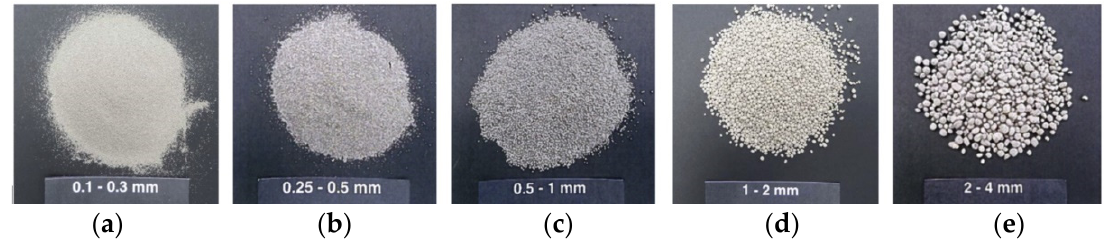
Figure 2. Appearance of LWAs: Expanded waste glass aggregates with 5 different diameters of ( a ) 0.1–0.3, ( b ) 0.25–0.5, ( c ) 0.5–1, ( d ) 1–2, and ( e ) 2–4 mm, respectively.